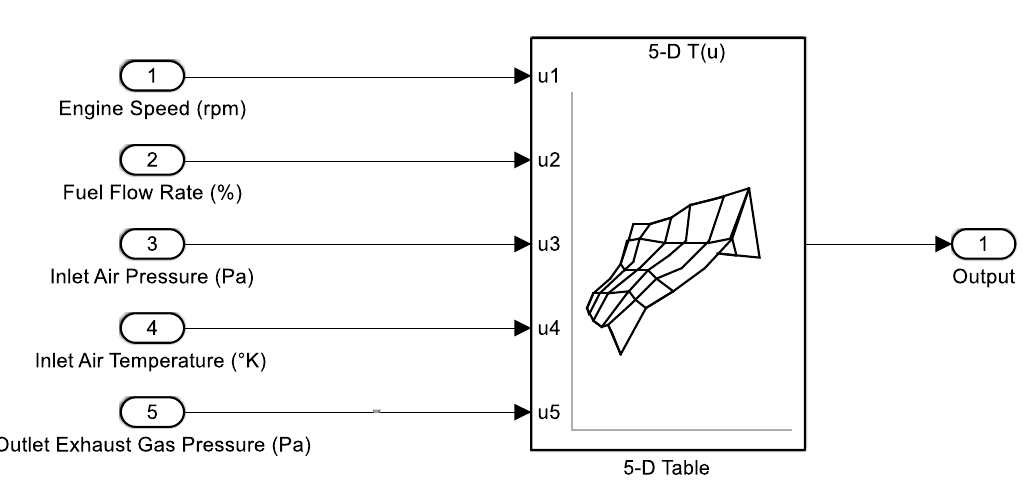
Table 1. General Electric ( GE) marine 12V 228 four stroke diesel engine main data. MCR = maximum continuous rating; bsfc = brake specific fuel consumption.